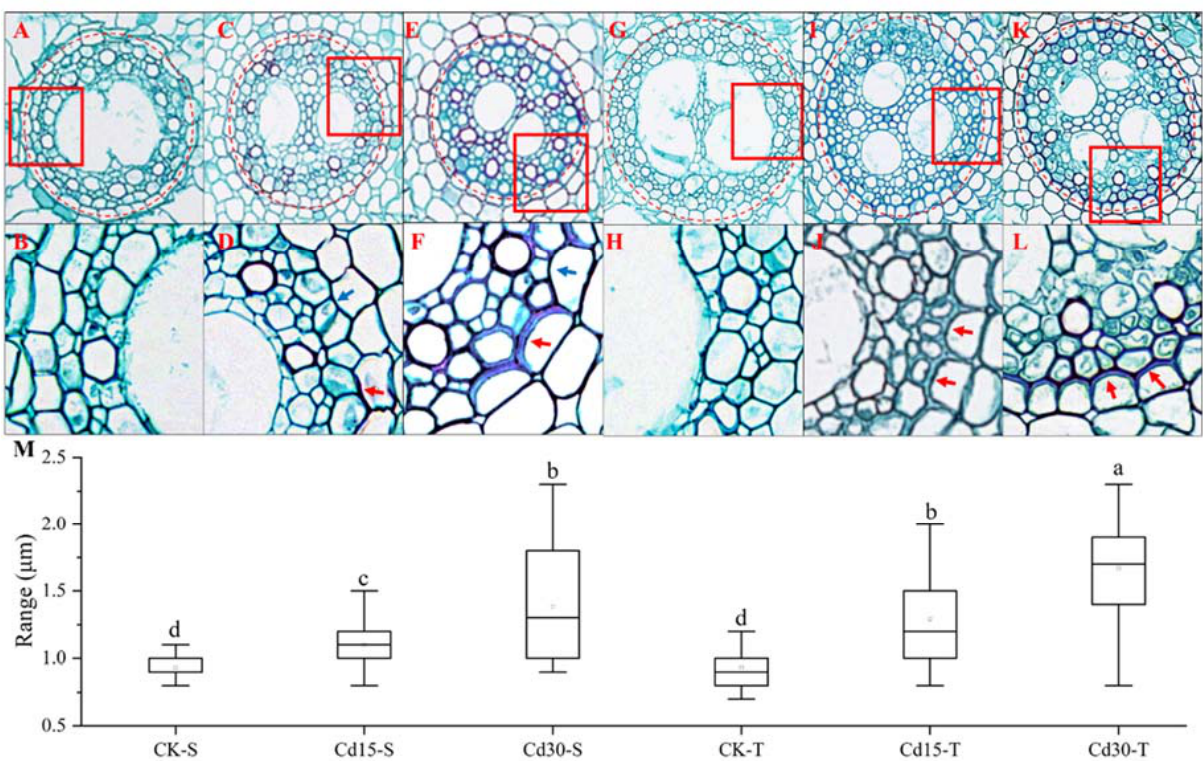
Figure 2. Effect of Cd stress on root microphotographs and cell wall thickness of broomcorn millet. ( A , C , E ) Optical micrographs of Cd-sensitive variety under control conditions (CK-S), 15 µ mol/L Cd stress treatment (Cd15-S), and 30 µ mol/L Cd stress treatment (Cd30-S), respectively. ( G , I , K ) Optical micrographs of Cd-tolerant variety under control conditions (CK-T), 15 µ mol/L Cd stress treatment (Cd15-T), and 30 µ mol/L Cd stress treatment (Cd30-T), respectively. Partial magnified images of ( A , C , E , G , I , K ) (red boxed areas) are shown as ( B , D , F , H , J , L ), respectively. ( M ) Statistics of cell wall thickness of the cells labeled by red circles. Cd-sensitive and Cd-tolerant cultivars. The red arrows represent obvious thickness of the cell wall, while blue arrows represent not obvious thickness of the cell wall. Different lowercase letters indicate significant differences in mean values at a p < 0.05 threshold among different Cd treatments and